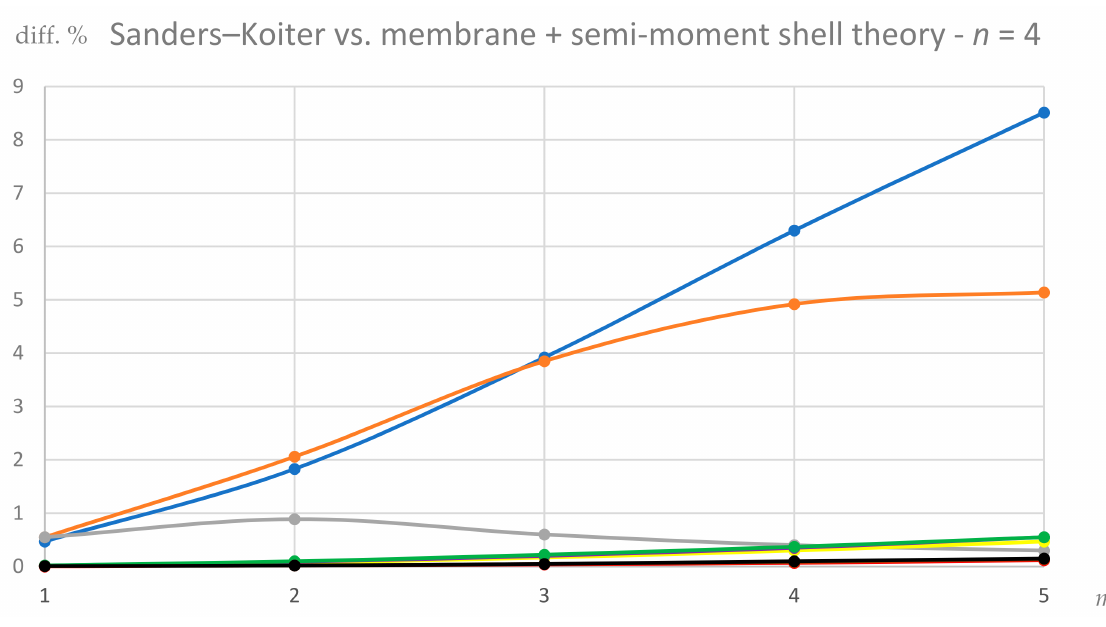
Figure 14. Simply supported DWCNT of Table 1 with different values of aspect ratio L / R 2 and thickness ratio R 2 / h . Shell-like modes ( n = 4). Comparisons between extended Sanders–Koiter and membrane + semi-moment shell theory, where L / R 2 = 10, R 2 / h =